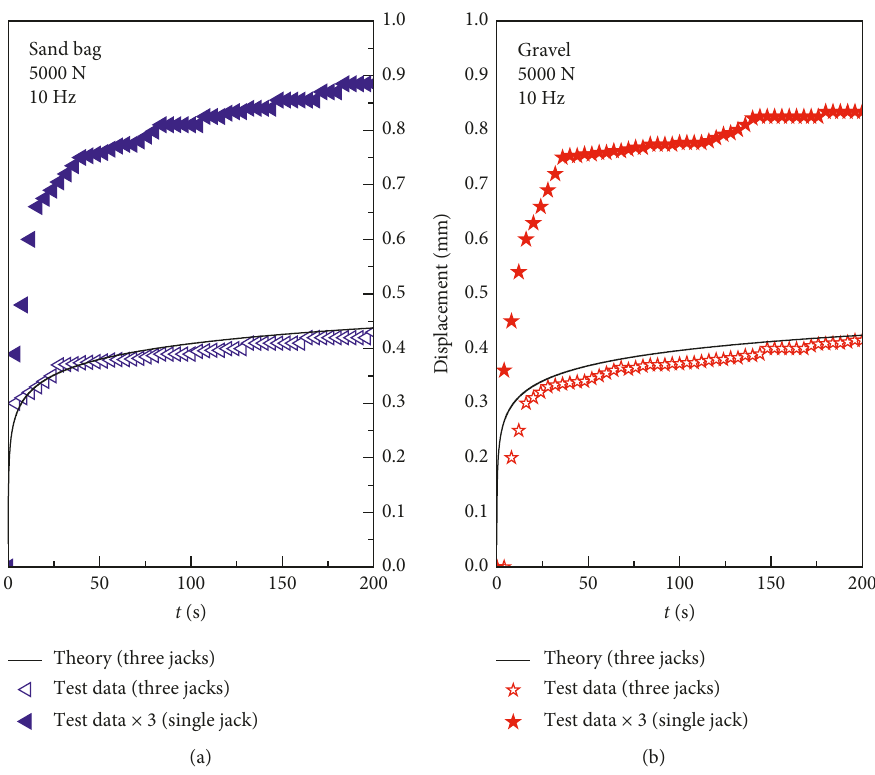
Figure 7: Variation in the displacement versus time curves: (a) sand bag and (b) gravel.